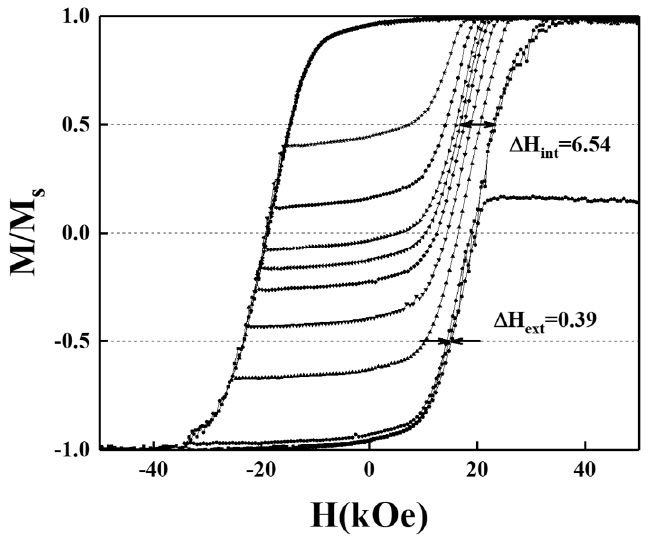
Figure 15. Magnetization curves include major and minor hysteresis loops of the FePtCAg/MgTiOBN film. Switching field distribution was evaluated by measured loops.